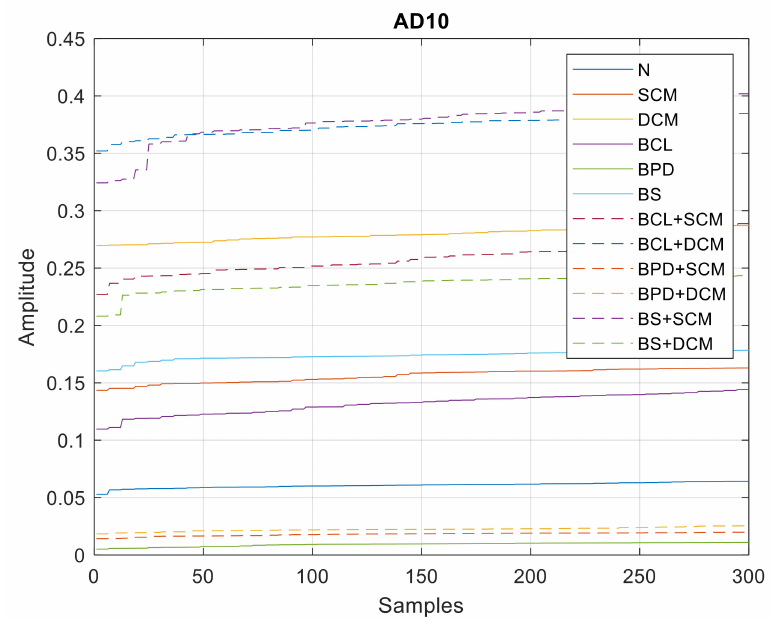
Figure 24. AD10 values—single and double/simultaneous faults.